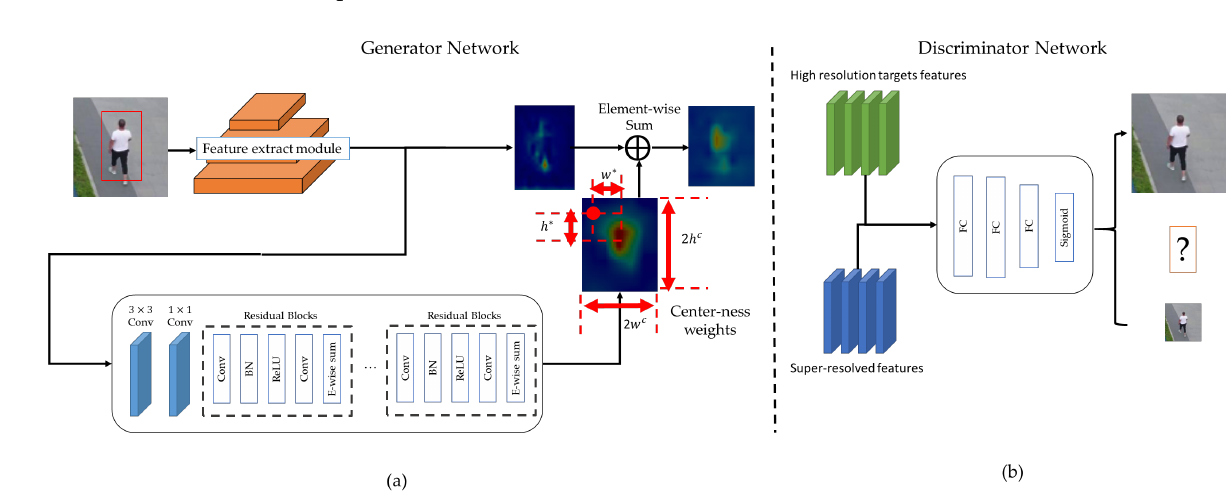
Figure 7. Details of the training procedure for the weight-GAN sub-network that uses super-resolved feature generation and discrimination. ( a ) shows the network generator, which contains a deep residual network to enhance the features from the feature extraction module. In the meantime, the center-ness weight aims to suppress the features of the edges. ( b ) shows the framework for the supervision and differentiates whether the image has high resolution target features or super-resolve features.